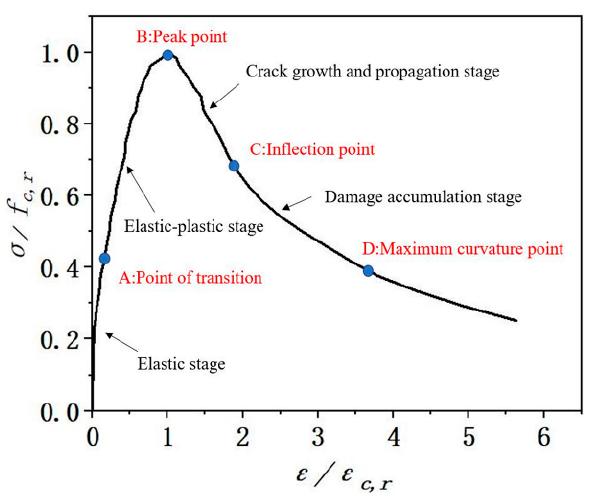
Figure 14. Typical uniaxial compression stress–strain curve of concrete. Where ε c,r is the peak strain, and f c,r is the peak stress. In this study, Equation (11) was adopted from the constitutive relation presented in the Code for Design of Concrete Struc- tures (GB50010-2010). The curve consists of ascending and descending sections, the shapes of which are controlled by the independent parameters n and 𝛼 , respectively. As shown in Equation (12), the parameter n is identified by peak strain, the secant modulus, and peak stress of concrete, and reflects the stress–strain curve characteristics of the rising section of concrete. The parameter α determines the stress–strain curve characteristics of the falling section of concrete. The larger the value of 𝛼 , the steeper the descending section of the stress–strain curve. The change in the magnitude of α value can reflect the changing characteristics of the concrete stress–strain curve. The concrete plastic deformation prop- erties deteriorate as 𝛼 increases.